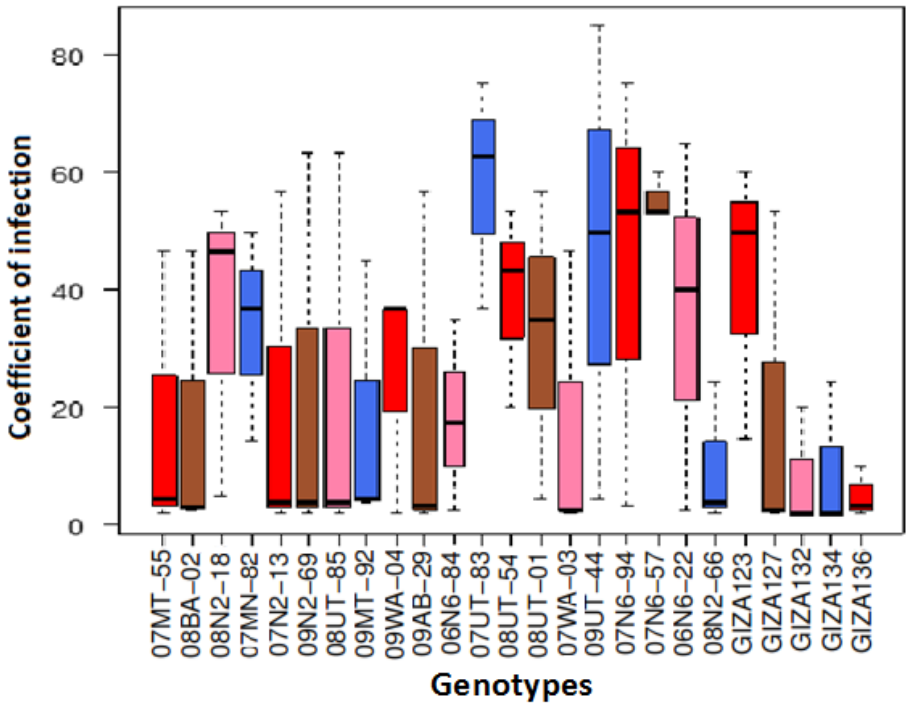
Figure 2. Boxplots for the mean coefficient of infection for leaf rust (LR) for 25 genotypes across the three environments. Three genotypes (07UT-83, 08UT-54, and 09UT-44) exhibited a susceptible response for powdery mildew (PM) disease, where they recorded 6, 6, and 8, respectively. The Egyptian cultivars (Giza134 and Giza127) exhibited a high resistance response for PM, where they recorded 0.66 and 1.6, respectively. Cultivars, Giza132, Giza136, and Giza123 exhibited a moderately resistant response for PM, where they recorded 2.6, 2, and 3, respectively (Supporting Information, Table S6).